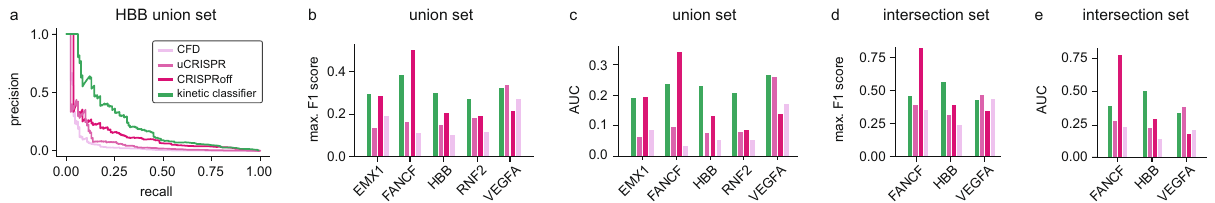
Fig. 7 Genome-wide off-target classi fi cation. a PR curves on the HBB gene using the CFD score (light purple), uCRISPR score (purple), CRISPRoff (dark purple), and our kinetic classi fi er (green). The precision and recall is calculated over all targets in the genome with a canonical PAM site, taking all experimentally validated off-targets as true positives. b) max. F1 scores for target sites EMX1, FANCF, HBB, RNF2 and VEGFA site 1 using all experimentally identi fi ed off-targets as true positives (union set) (Supplementary Fig. 3). c AUC scores for the same target sites and true positives as in Fig. 7b. d